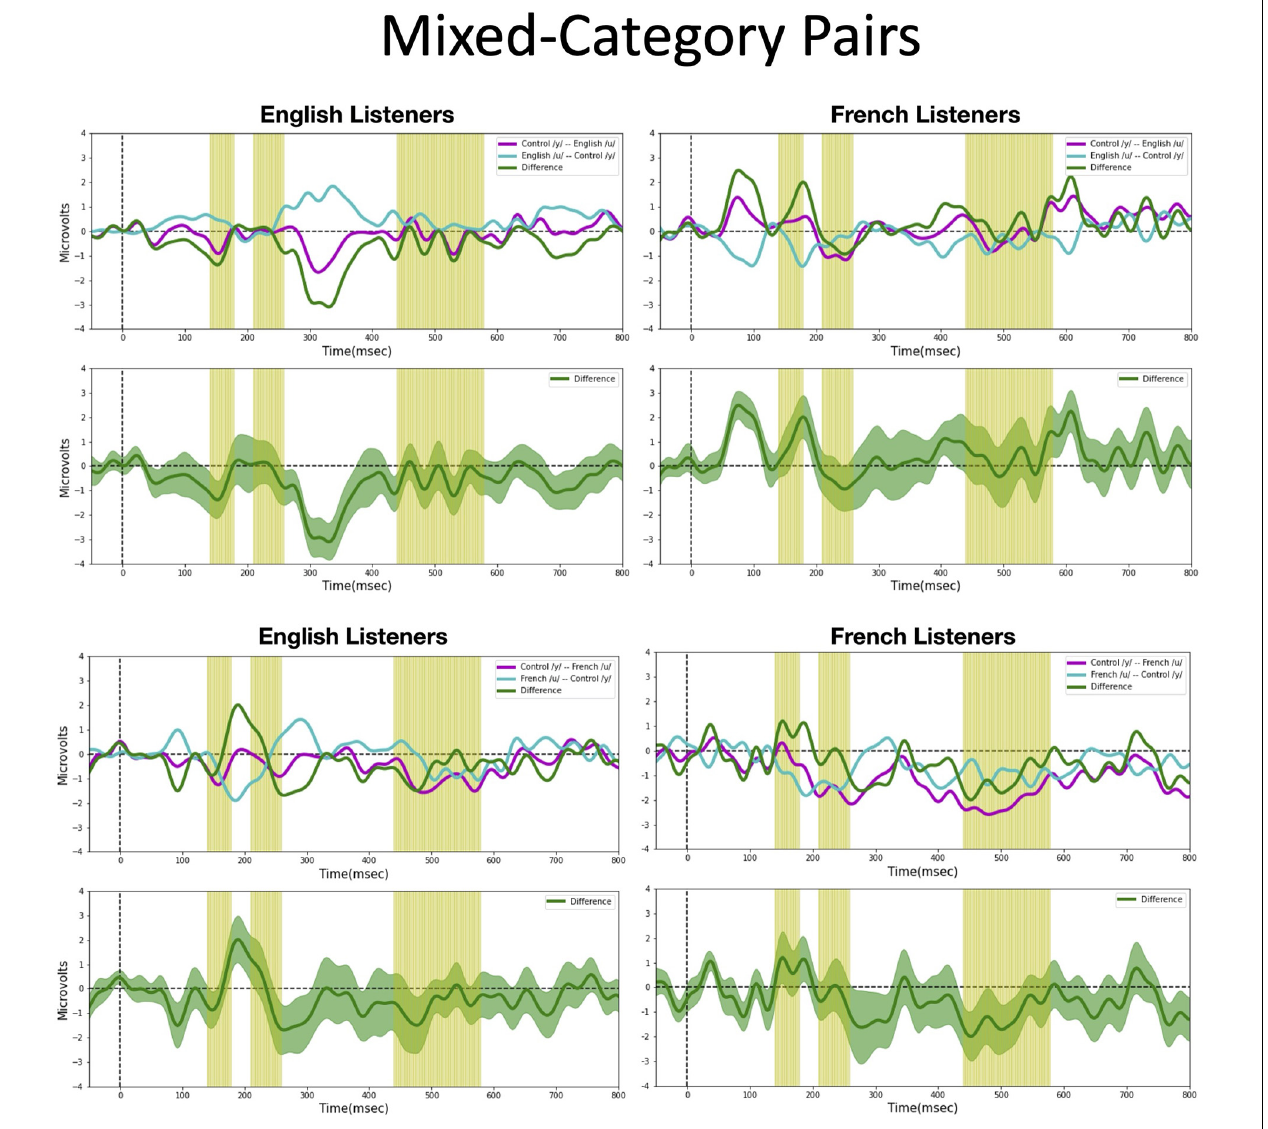
FIGURE 7 | Mismatch negativities (as described in Figure 3C ) for each stimulus type: Mixed-category pairs . the mean MMNs for each stimulus presentation order (purple and turquoise lines) and difference waveform (green lines) (in the top half of each panel) and the difference waveform plotted with the standard error for the group (as the dark green shaded region) in the bottom half of each panel. The light green shading indicates the pre-selected time windows used in the hypothesis-based anayses. The MMNs are plotted for each language group wth English Listeners on the left and French Listeners on the right. The vowel pair for each MMN is indicated in the legend at right hand corner of each panel with the standard followed by the deviant (e.g., French /y/ – French /u/ denotes an MMN with French /u/ (V1) as the deviant in the context of French /y/ (V4) as